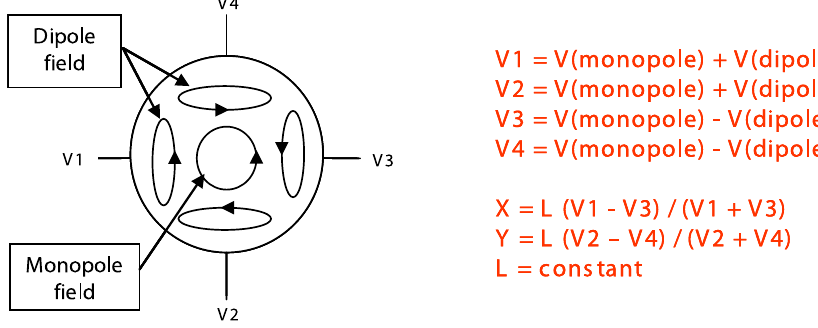
FIG. 2. (Color) Link between oscillation modes and beam